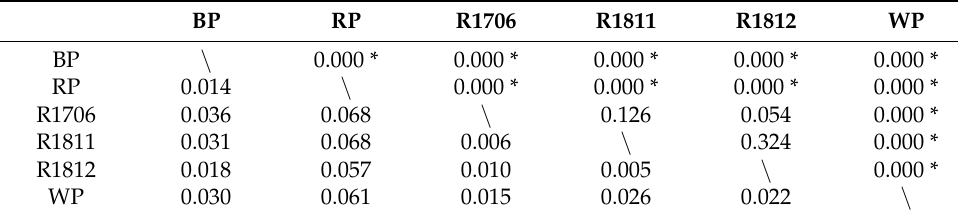
Table 3. Pairwise Fst between six populations of black sea